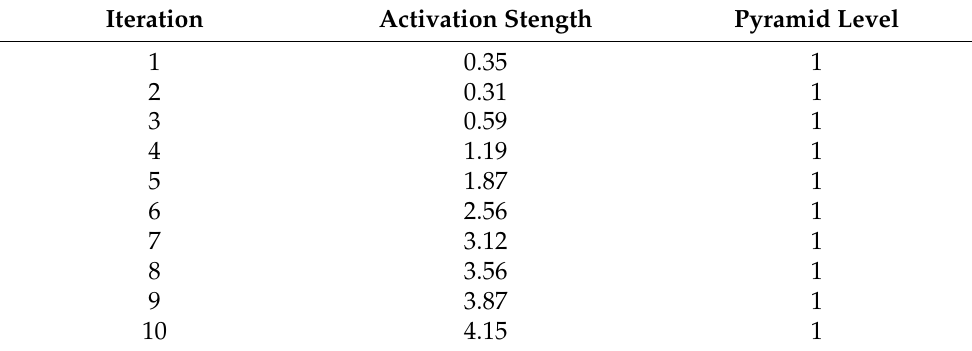
Table 3. Activation strength on 56 features learned by the average pooling layer for